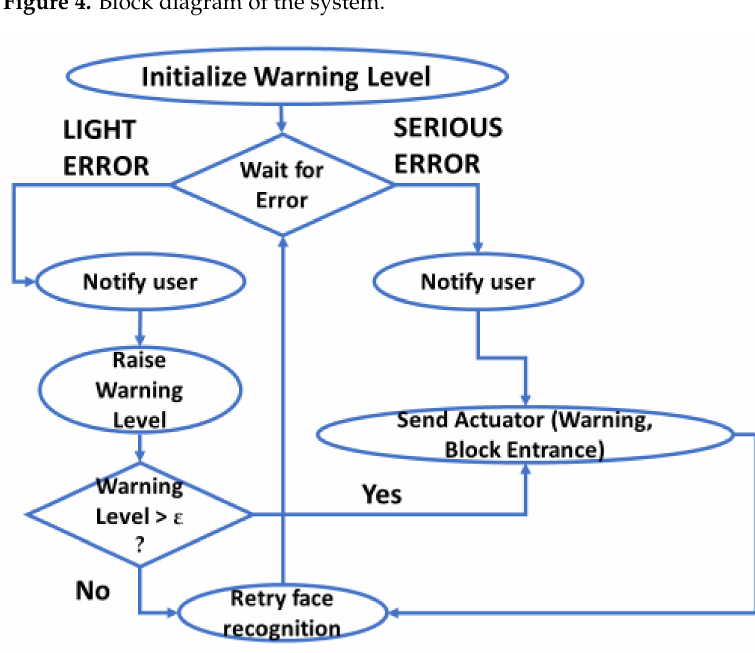
Figure 5. Flow diagram of the decision